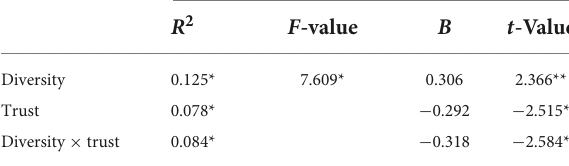
TABLE 5 Moderated regression